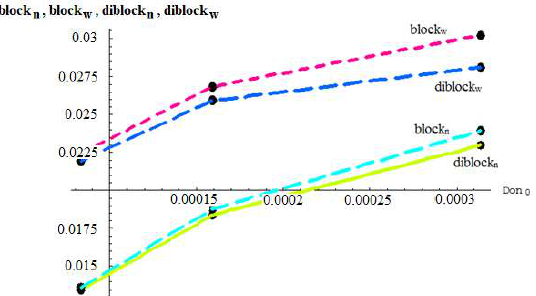
Figure 10. Comparison of the dependences on the initial electron donor concentration of molar and mass (or weight) fractions of stereoblock and diblock chains synthesized at the residence time in the reactor τ = 60 min.